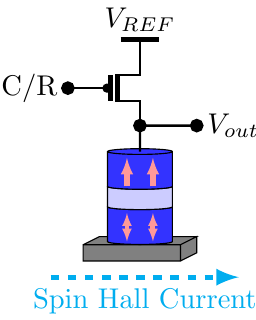
Figure 12. Comparator proposed in Reference